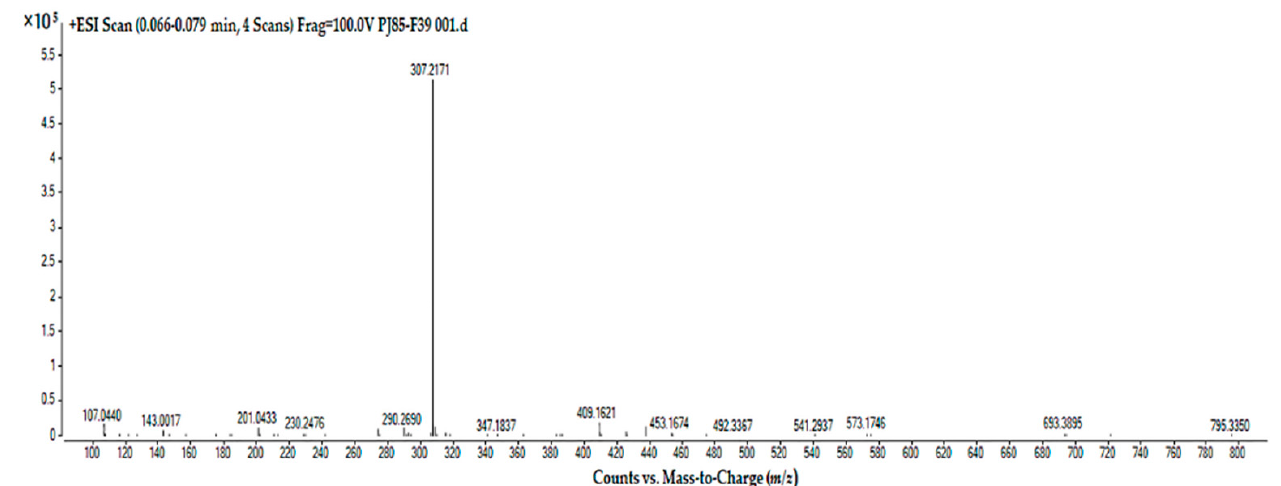
Figure 5. Liquid chromatography–mass spectrometry (LC–MS) analysis of compound PJ85_F39 in positive ion mode. MS spectrum showing the ion clusters for [M + H] + at m / z 307.2171 correlated to dihomo- γ -linolenic acid (DGLA). Table 4. The nearest chemical compounds when matched to MassBank database detected in compound PJ85_F39 of Streptomyces sp. PJ85.